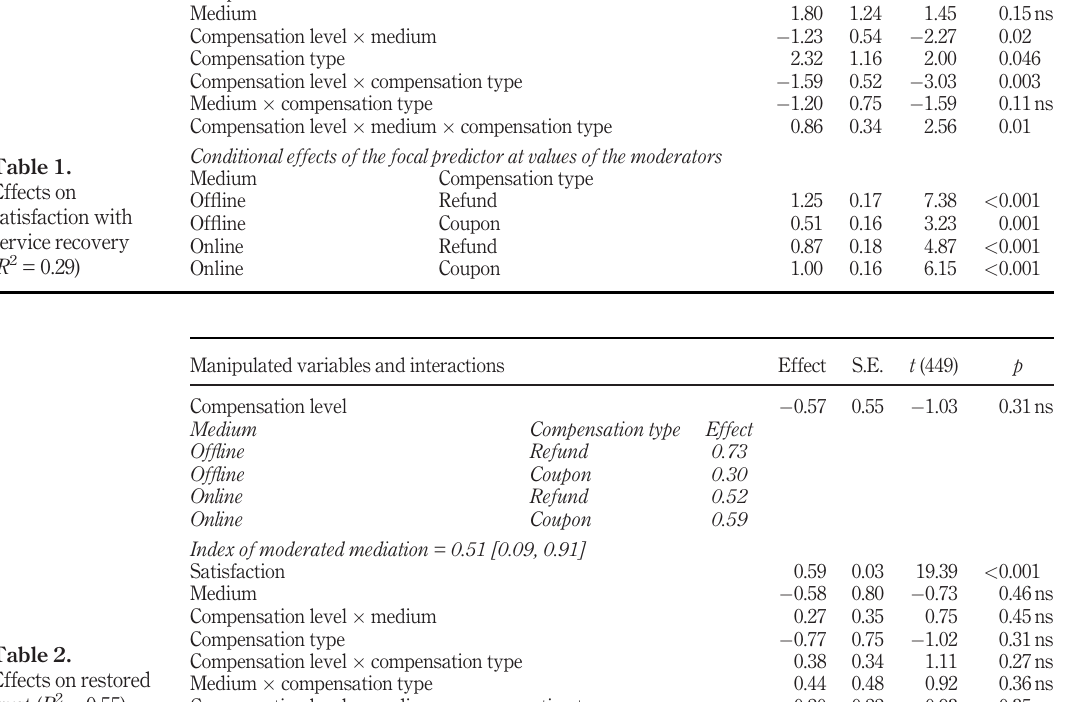
Table 2. Effects on restored trust ( R 2 = 0.55)